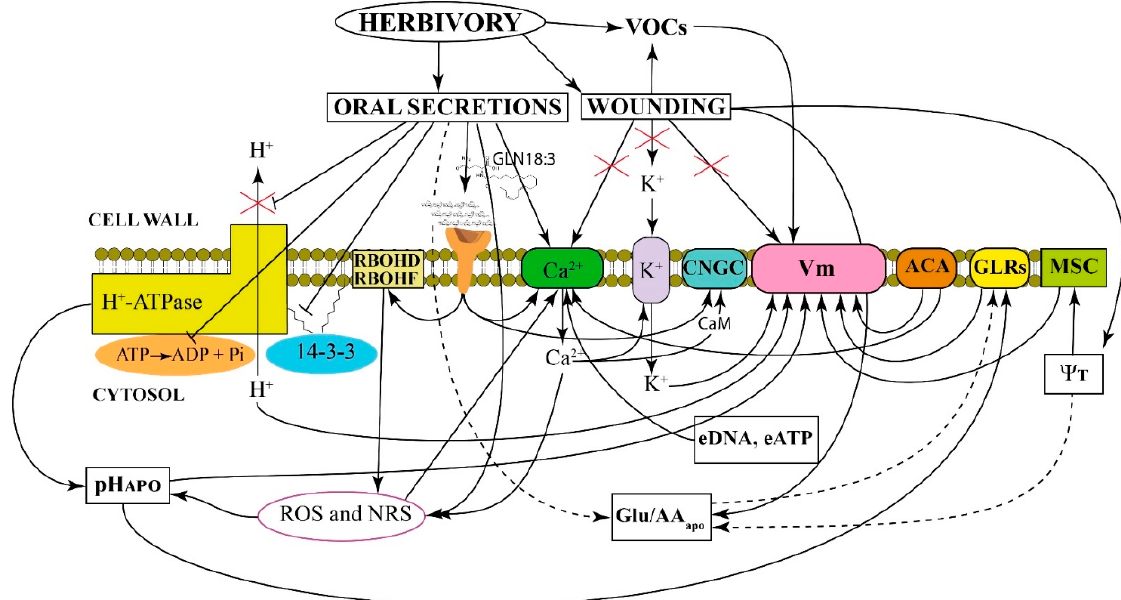
Figure 1. Framework of early events induced in responses to herbivory within the first minutes after infestation. Herbivory is the combination of tissue damage (wounding) and the delivery of insect oral secretions. Both herbivory and mechanical damage induce the emission of volatile organic compounds (VOCs), which depolarize the plasma membrane potential (Vm). Wounding induces variations in the water potential that affect the turgor pressure ( Ψ T ), which is perceived by plasma- membrane located mechanosensitive ion channels (MSC) resulting in Vm depolarization. Type IIB auto-inhibited Ca 2+ -ATPases (ACAs) play a role in recovery of excitability after long-term herbivory by interfering with both the Vm and [Ca 2+ ] cyt . Mechanical wounding does not exert a direct effect on Vm, Ca 2+ and K + channel activity (red crosses). Herbivory delivers oral secretions that exert different effects. Upon herbivory receptors activate a plasma-membrane–localized cyclic nucleotide-gated ion channel (CNGC) which interacts with the Ca 2+ -sensor calmodulin (CaM). Oral secretions inhibit the H + -ATPase activity by hampering the association between 14-3-3 protein and H + -ATPase proteins and cause a reduced phosphohydrolitic activity of the proton pump with a reduced extrusion of H + from the cytosol and an alkalinization of the apoplast (pH APO ), both concurring to the Vm depolarization. Elicitors from oral secretions like N -linolenoyl- L -glutamine (GLN18:3) induce a RBOHD and RBOHF-dependent ROS burst. Specific oligosaccharides present in the oral secretions interact with plasma membrane receptors that also trigger ROS and Ca 2+ signaling. Extracellular DNA (eDNA), deriving from cell disruption made by herbivory, and extracellular ATP (eATP) released by wounding and herbivory increase [Ca 2+ ] cyt . In summary, oral secretions, wounding, Ψ T reduction, pH APO alkalinization, an increase in apoplastic amino acids (AAapo) and glutamate (Glu) and the activity of the glutamate receptor-like cation channels (GLRs) depolarize the Vm. Oral secretions and ROS/NRS activate the Ca 2+ channel that in turn opens the inward rectifying K + channel that reduces the cytosolic pH causing Vm depolarization. Connections supported by empirical studies in planta are represented by solid lines, hypothetical connections are shown in dashed